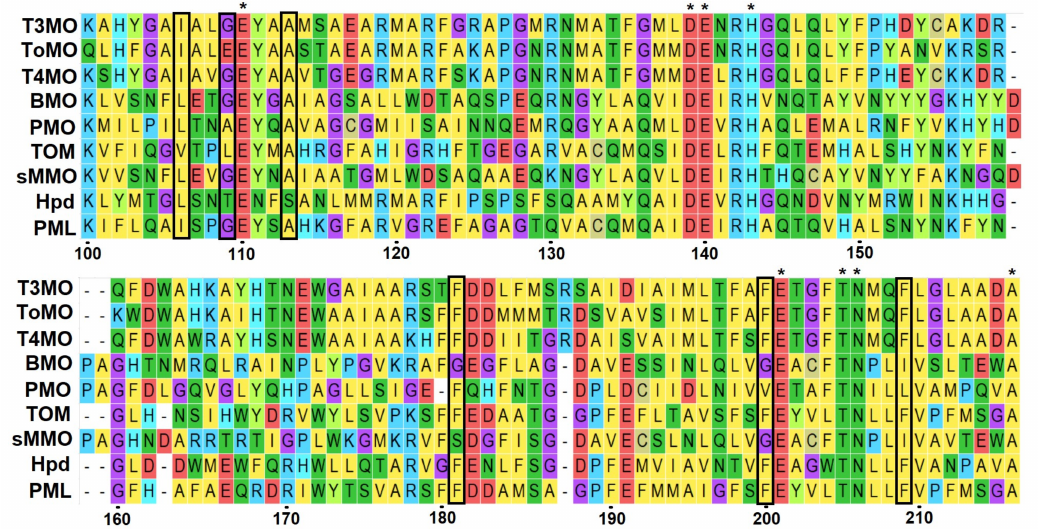
Figure 1. The protein sequence alignment between well-studied SDIMOs α subunits. Toluene 3-monooxygenase (T3MO) of Ralstonia picketii PKO-1, toluene-o-xylene monooxygenase (ToMO) of Pseudomonas stutzeri OX1, toluene 4-monooxygenase (T4MO) from Pseudomonas mendocina KR1, butane monooxygenase (BMO) from Thauera butanivorans , propene monooxygenase (PMO) from Mycobacterium sp. M156, toluene 2-monooxygenase (TOM) from Burkholderia cepacia G4, soluble methane monooxygenase (sMMO) from Methylococcus capsulatus Bath, 2-hydroxypyridine 5-monooxyganase HpdABCDE (Hpd) from Burkholderia sp. MAK1, PmlABCDEF (PML). The numeration is based on PML protein